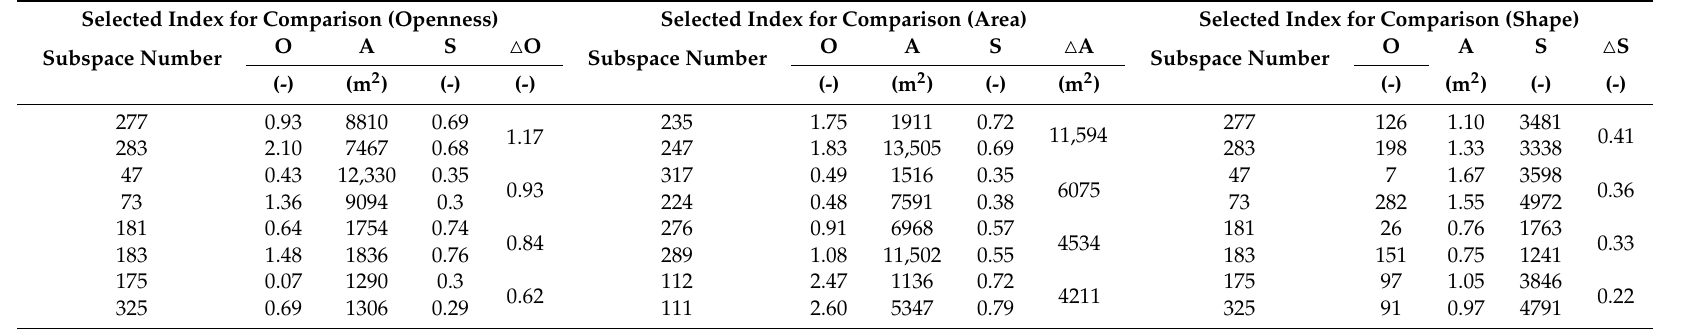
Table 3. Spatial characteristic indices of 24 selected